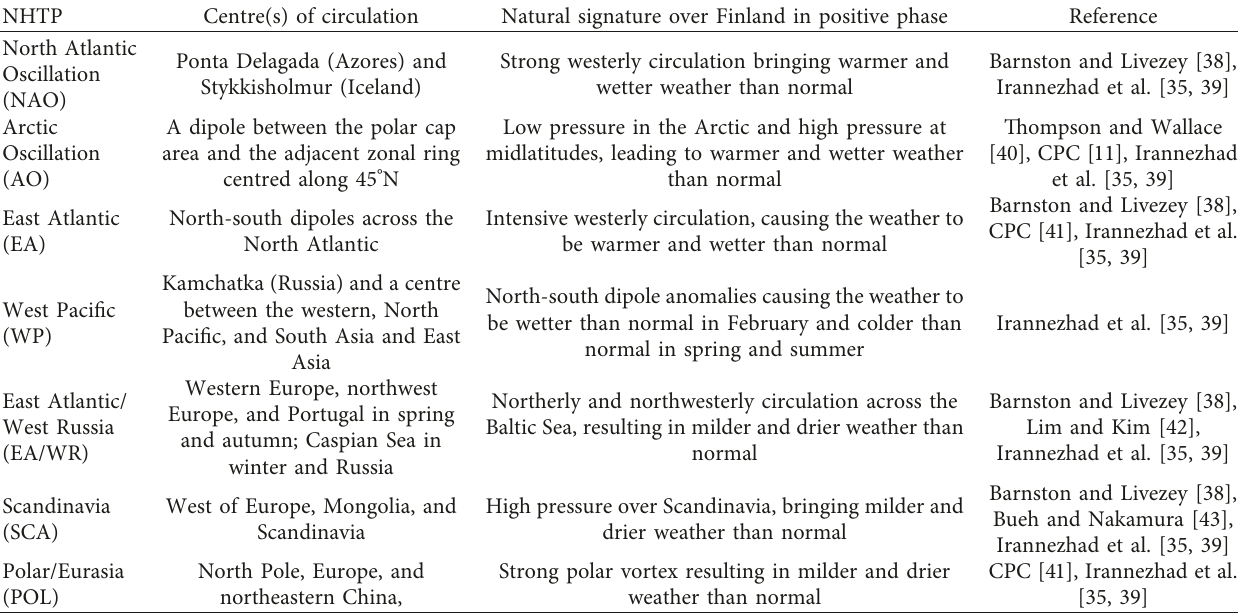
Table 2: Summary of the Northern Hemisphere teleconnection patterns (NHPs) affecting climate variability in Finland considered in this